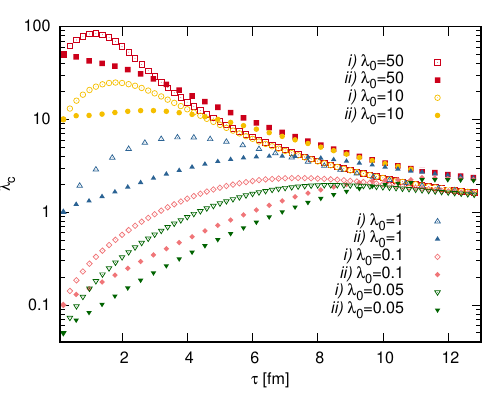
Figure 2. Charm quark fugacity as a function of time for di ff erent initial values λ 0 . The open bullets show λ c in the i ) case of perfect QGP propagating longitudinally, while full symbols represent the ii ) evolution of hot QCD medium expanding in (2 + 1)D, with temperature-dependent shear viscosity taken into account.